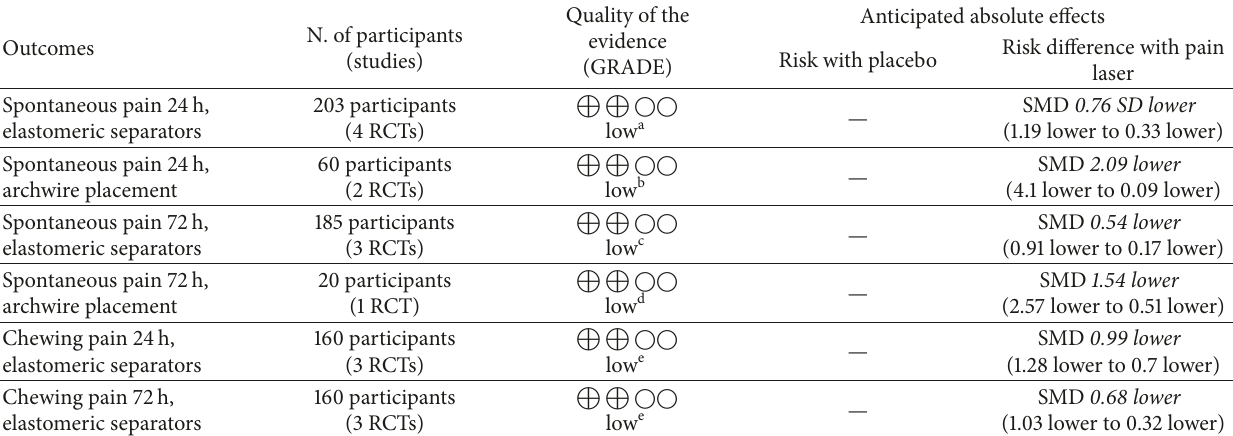
Table 4: GRADE quality evidence.